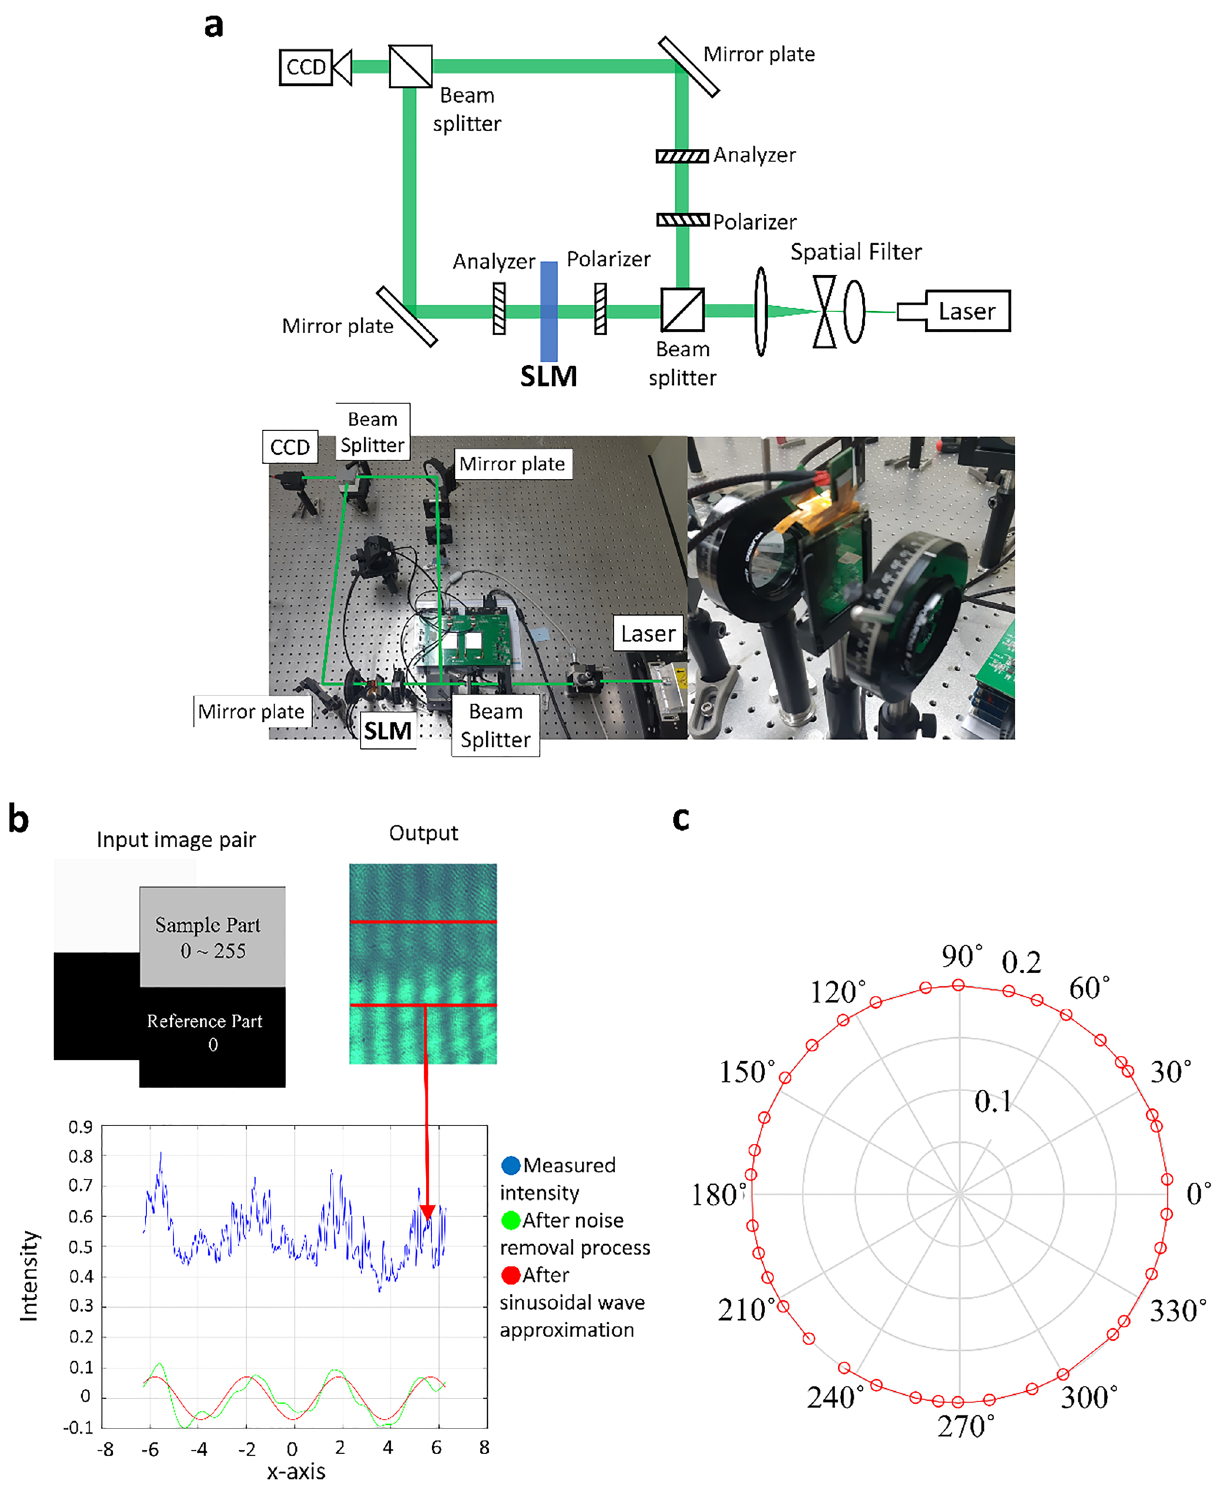
Figure 4. ( a ) Schematic (upper panel) and actual setup (lower panel) of the Mach–Zehnder interferometer for the modulation characterization of the dual-layer IPS panel. ( b ) Two-section grayscale input image and the observed interference patterns, and the sinusoidal approximation process for the measured interference pattern. ( c ) Full 360-degree phase modulation characteristics of the dual-layer IPS